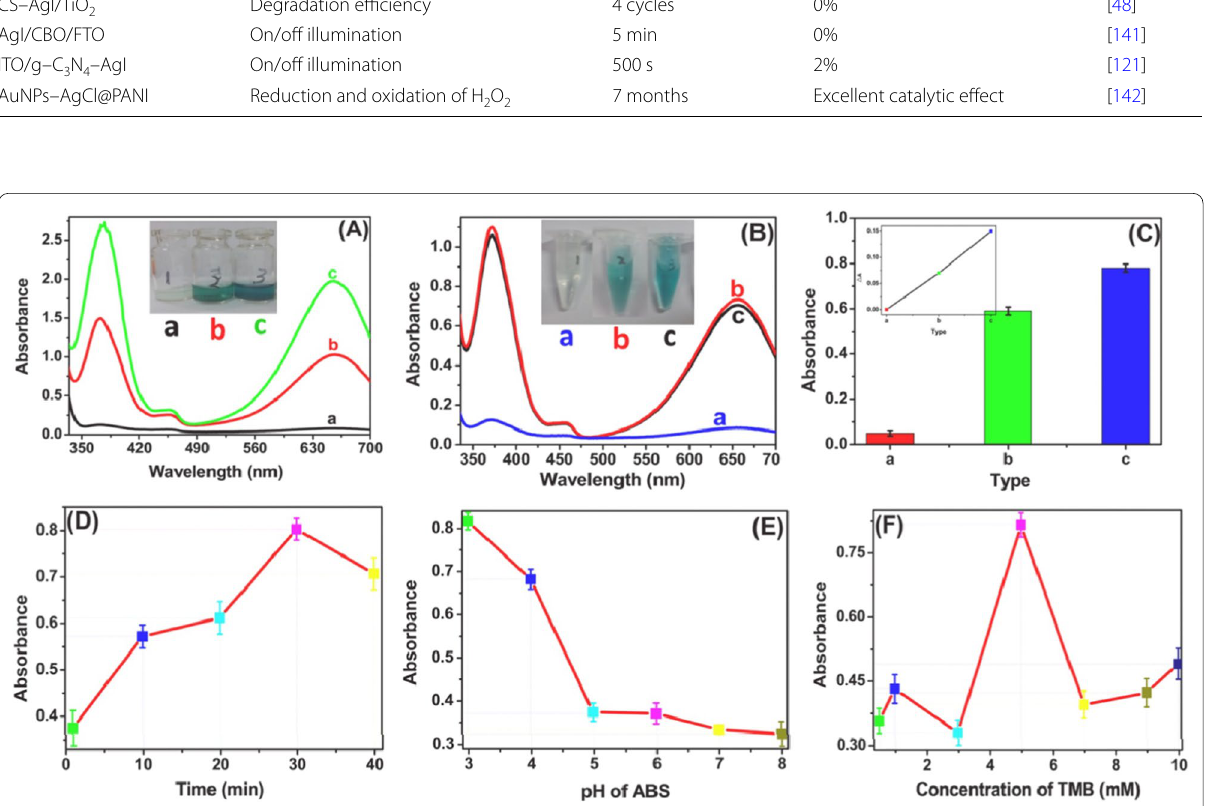
TMB, (b) AgI TMB, and (c) CS-AgI/TiO 2 TMB under visible light illumination [the inset is + + + TMB, (b) CS-AgI/TiO 2 TMB, and (c) Fe 3 O 4 CS–AgI/TiO 2 TMB; C the + + + +